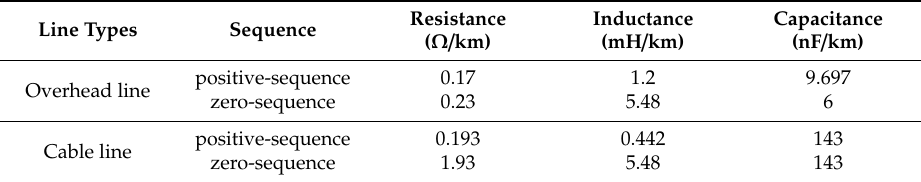
Table 1. Impedance parameters of transmission